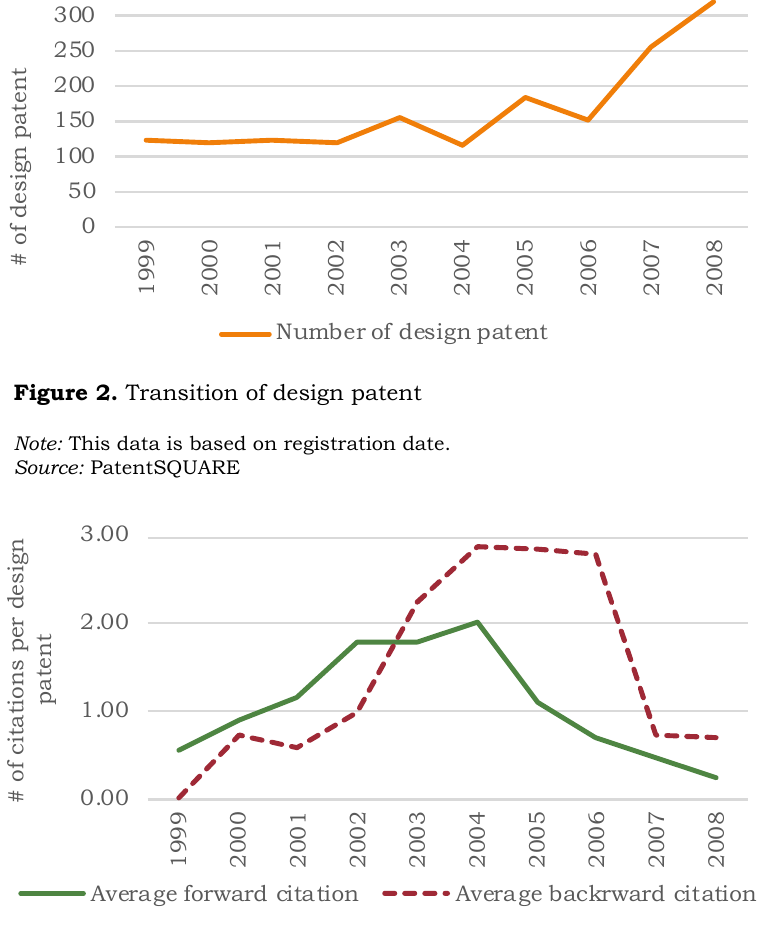
Figure 3. Transition of forward and backward